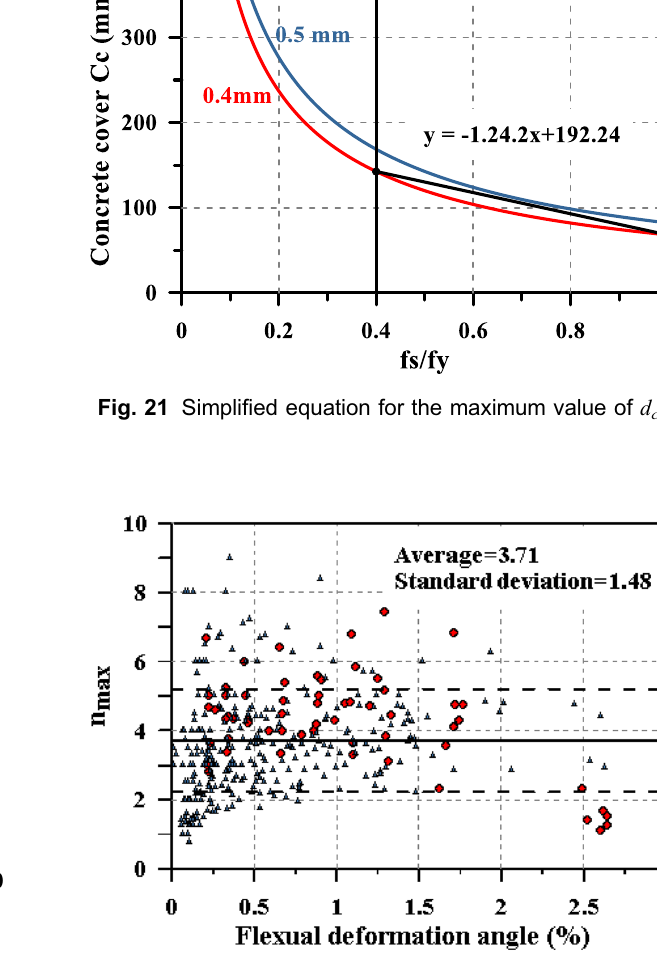
Fig. 22 Ratios of the maximum flexural crack width at the peak deformation angle and residual maximum flexural crack width (Circle points are the specimens in this work; triangle points are the specimens in the references (Chiu et al. 2014,